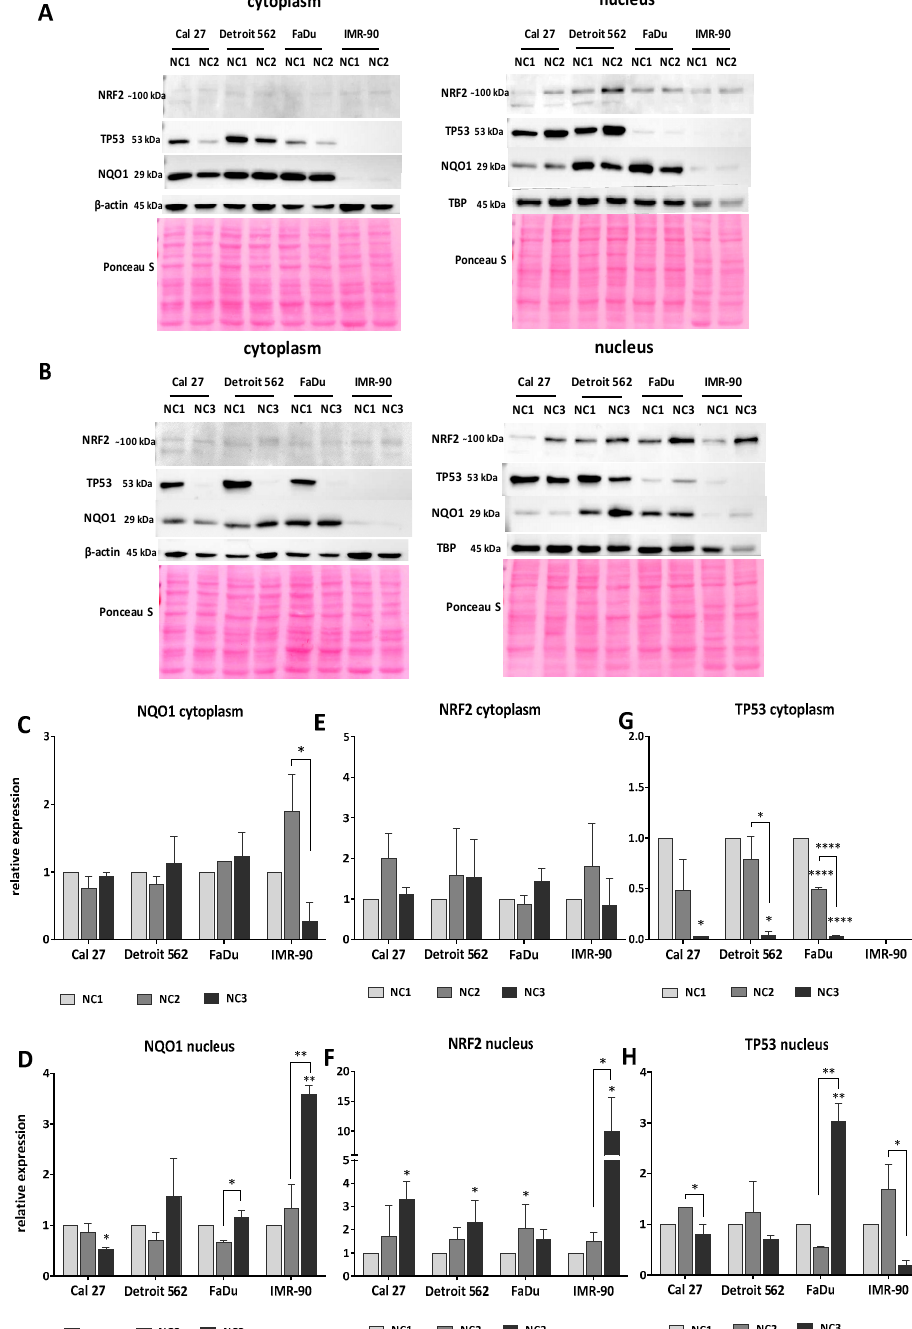
Figure 10. The expression of NQO1, NRF2 and TP53 in cancer cell lines and IMR-90. The representative western blots of cytoplasmic and nuclear NQO1, NRF2 and TP53 content under di ff erent nutritional conditions: ( A ) NC2 (low glucose + l -glutamine); ( B ) NC3 (no glucose and no l -glutamine). The relative expression is calculated as compared to the control condition (NC1 – high glucose + l -glutamine) for: C -cytoplasmic and D -nuclear NQO1; E -cytoplasmic and F -nuclear NRF2; G -cytoplasmic and H -nuclear TP53. One-way ANOVA with Tukey post hoc test was used to test the di ff erences in relative expression of selected proteins under di ff erent nutrient conditions. The values are shown as the mean ± SD. n = 3. * p < 0.05; ** p < 0.01; *** p < 0.001; **** p < 0.0001.